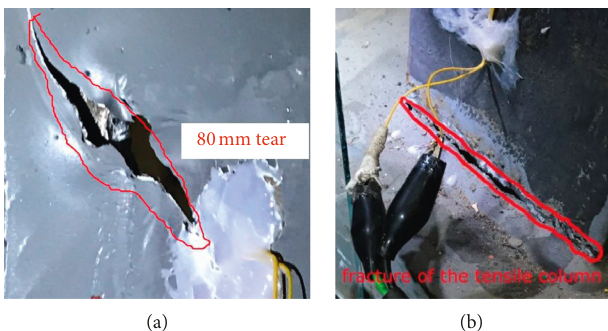
Figure 4: At the end of the test: (a) tear at the upper left corner and (b) failure at the support of the column in tension.